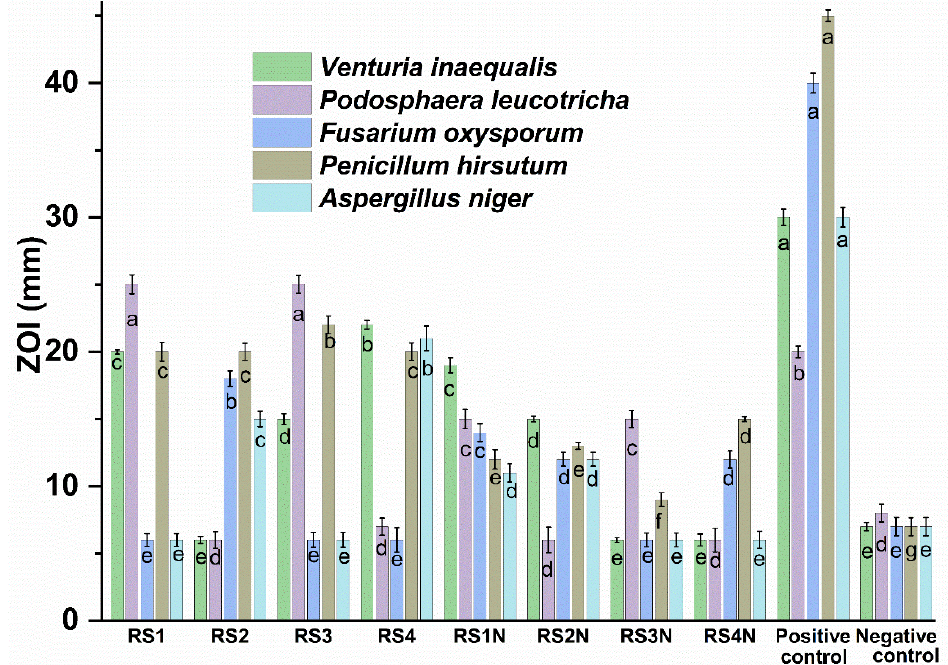
Figure 6. Antifungal activity of tested extracts against horticultural relevant fungi. For each strain, values without a common letter differ ( p < 0.05) as analyzed by one-way ANOVA and the Tukey